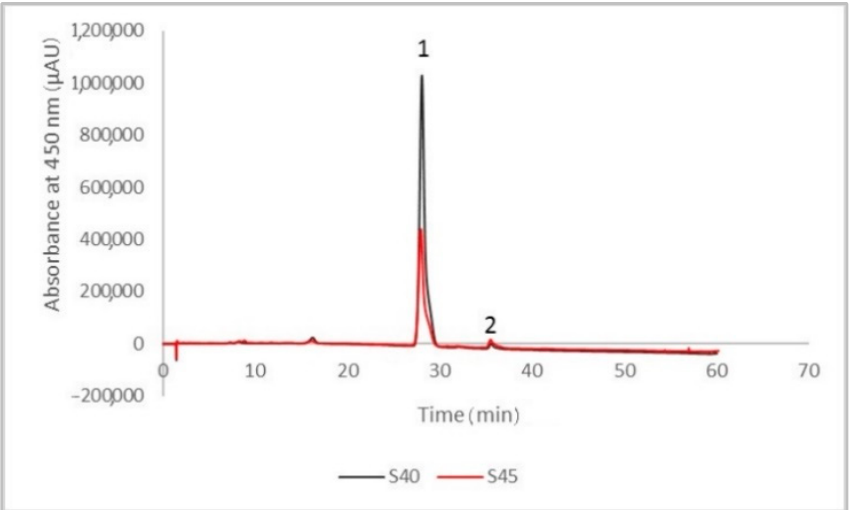
Figure 1. The chromatographic profile of the tomato peels supercritical CO 2 extracts at 450 nm (S40—the extract fraction separated at 20 Mpa in the first separator, S45—the extract fraction sepa- rated at 5 Mpa in the second separator), the major identified compounds being lycopene (peak 1) and β -carotene (peak 2).